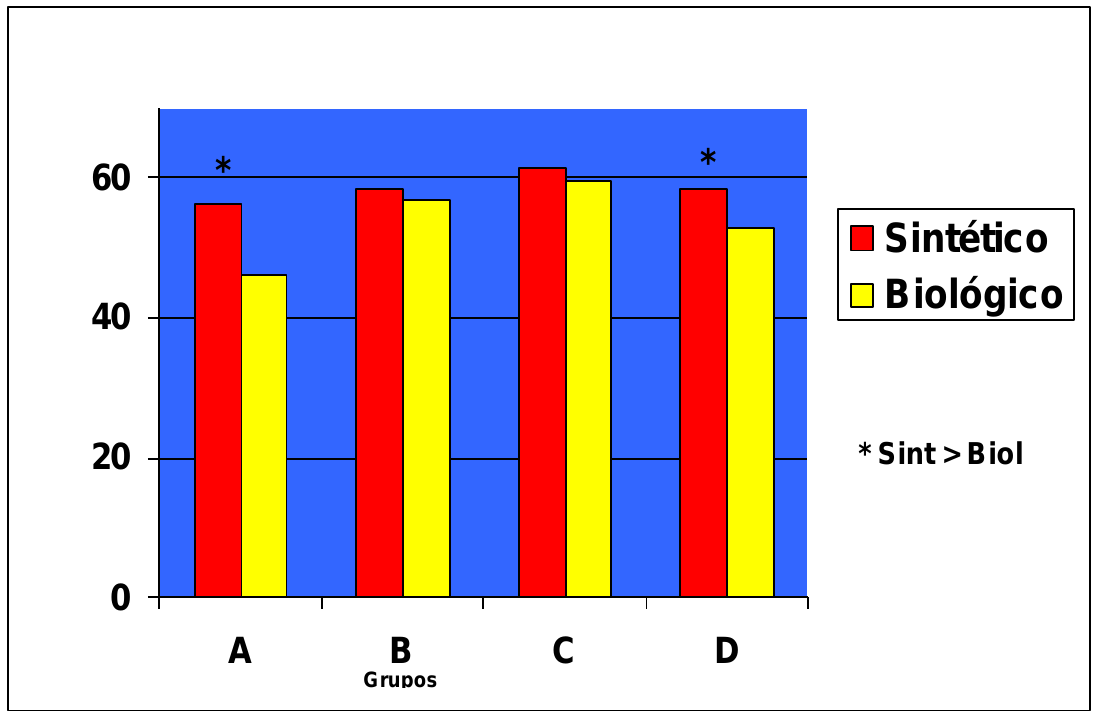
FIGURA 2 – Distribuição das médias do índice de estenose da anastomose jejuno-jejunal após síntese com adesivo sintético ou biológico entre dois(GA), quatro (GB),